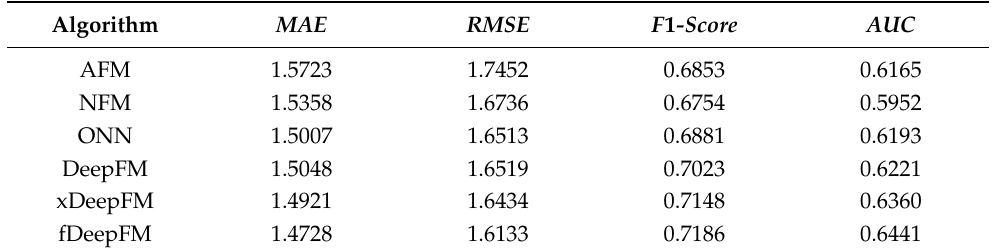
Table 3. Comparison experiments of algorithm effects under a different scale of sparsity.